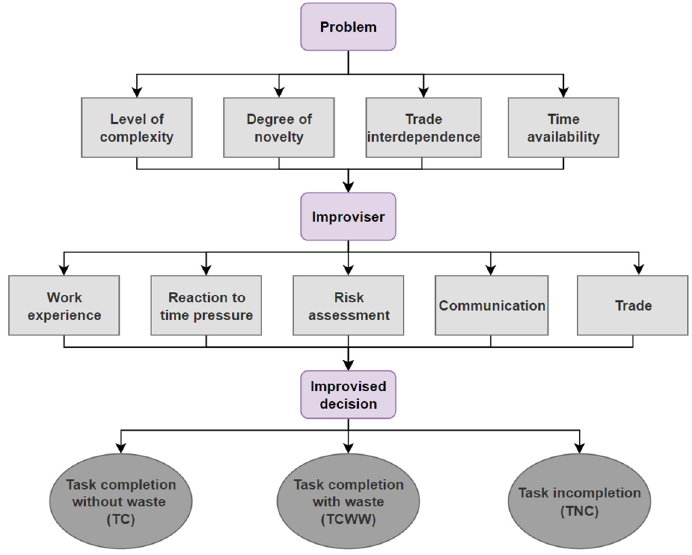
Figure 1. Conceptual framework.